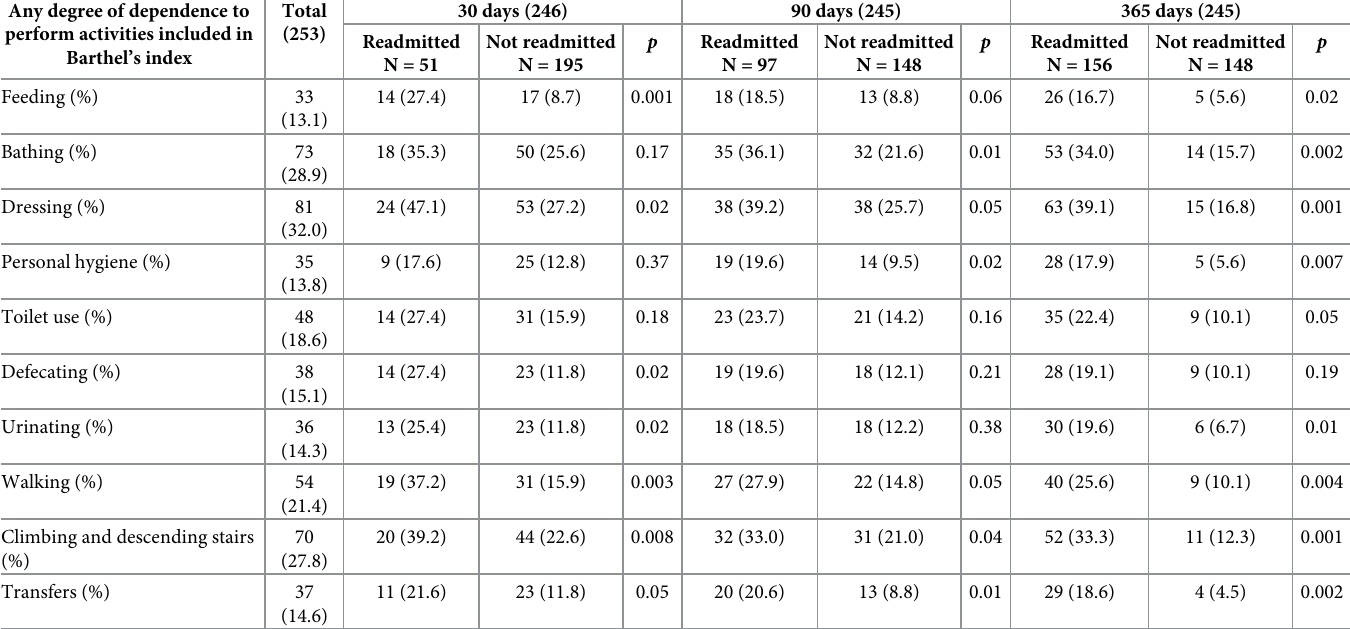
Table 4. Comparison between the dependence of the readmitted and the non-readmitted patients based on Barthel’s index and classified according to the three time